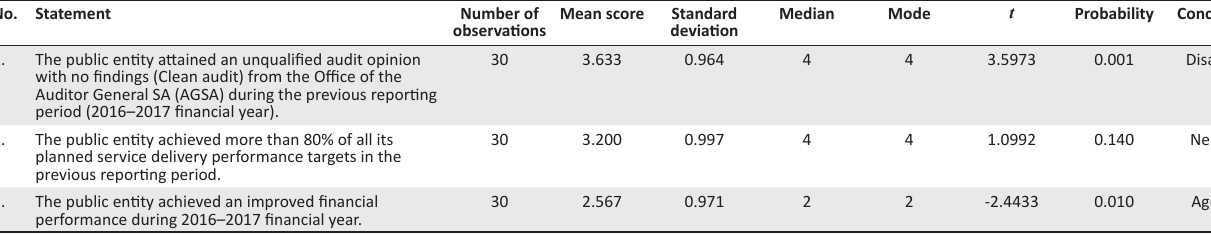
TABLE 1: Organisational performance.